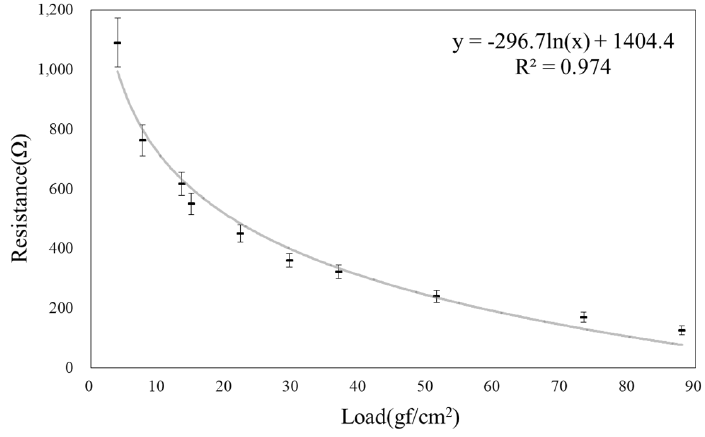
Figure 6. Load–resistance calibration curve of the conductive nonwoven MWCNT composite.